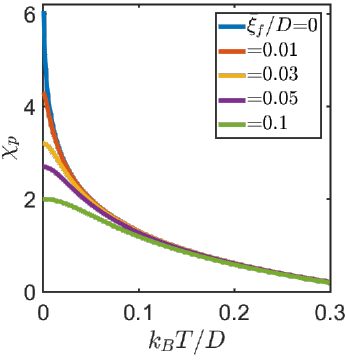
Figure 5: Static pair susceptibility at q = 0 as a function of temperature for different values of ¯ ξ . As expected from Eq. (51) the pair correlation function diverges at f → T → 0 for ¯ ξ f